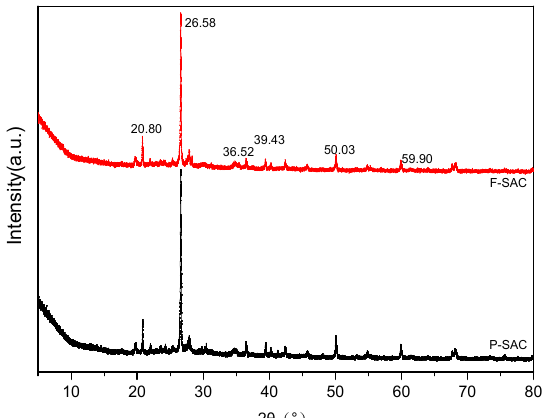
Figure 2. X-ray diffractometry (XRD) of Fenton-activated sludge-derived activated carbon (F-SAC) and untreated SAC (P-SAC).